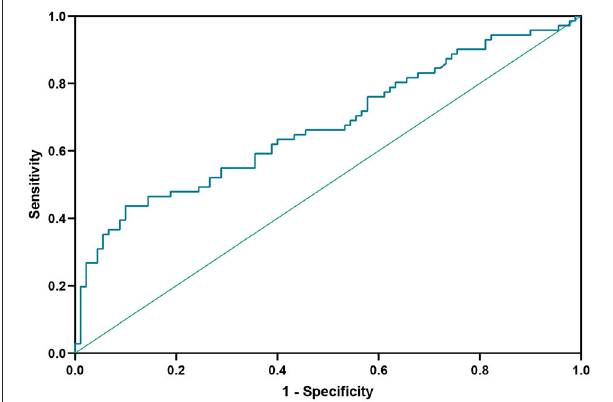
FIGURE 4 | Receiver operating characteristic (ROC) curve showing the predictive ability of Hcy for disease relapse. Hcy, homocysteine.